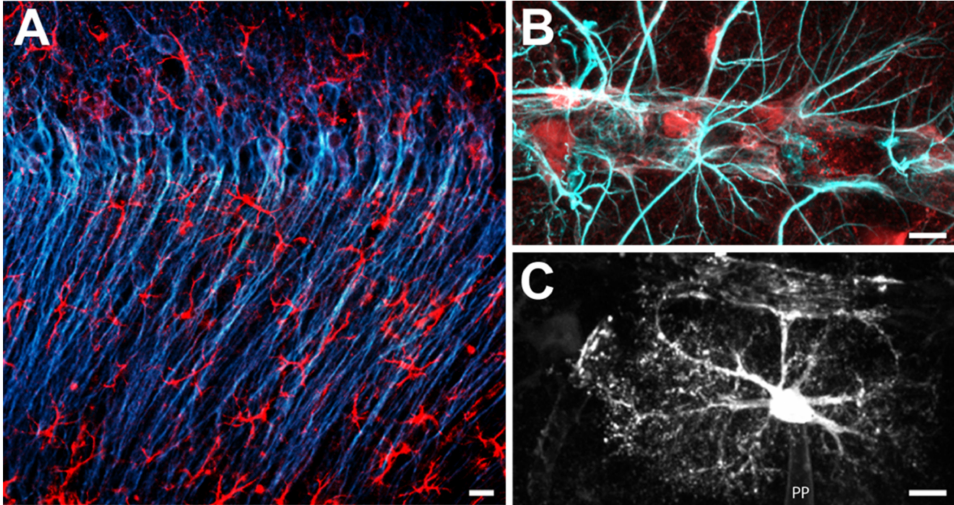
Figure 2. Astrocytes in the CA1 region of the mouse hippocampal formation. ( A ) Double- immunohistochemical labelling for the neuronal marker MAP-2 (blue) and for the astroglial marker GFAP (red). ( B ) Double-immunohistochemical labelling for the astroglial markers S-100 β (red) and GFAP (light blue) along a blood vessel. Note the many processes that terminate at or parallel the blood vessel. ( C ) Astrocyte, dye-filled via a patch pipette (PP). Scale bars: ( A ) 5 µ m; ( B , C ) 20 µ m. ATP is primarily used to enable the activity of ion pumps, most notably the Na + /K + - ATPase (NKA) [41,42], the Ca 2+ -ATPases of the plasma membrane (PCMA) and endoplasmic reticulum (SERCA) [34,43] and the H + -ATPase of presynaptic vesicles (v-ATPase) [44–46] (see Figure 3). Among these pumps, the NKA is the major cellular energy